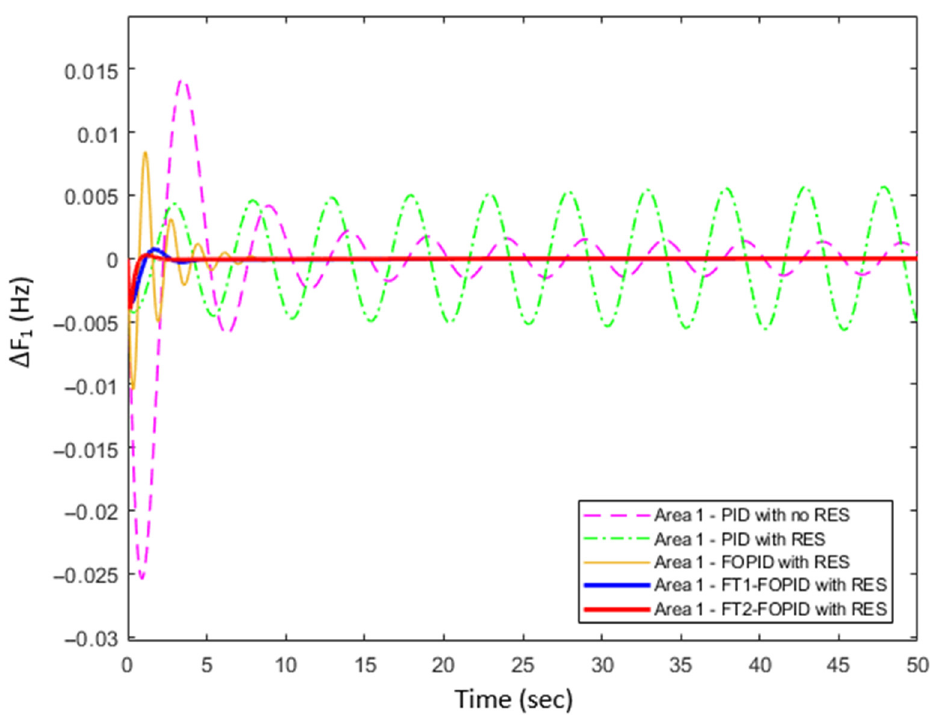
Figure 14. Results for 1% and 2% load alteration in Area 1.